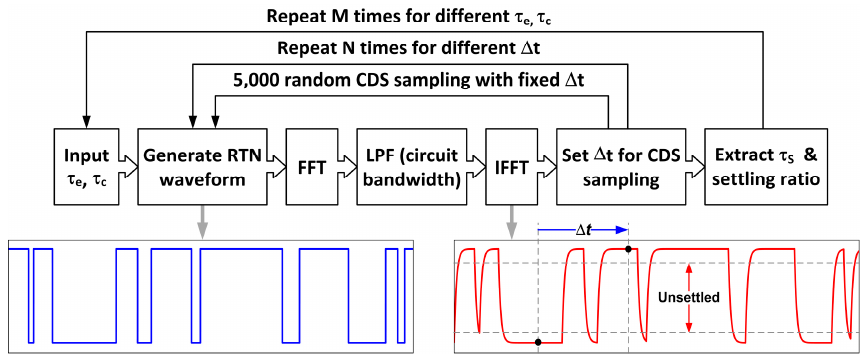
Figure 18. The RTN behavior model and simulation flow in MATLAB.